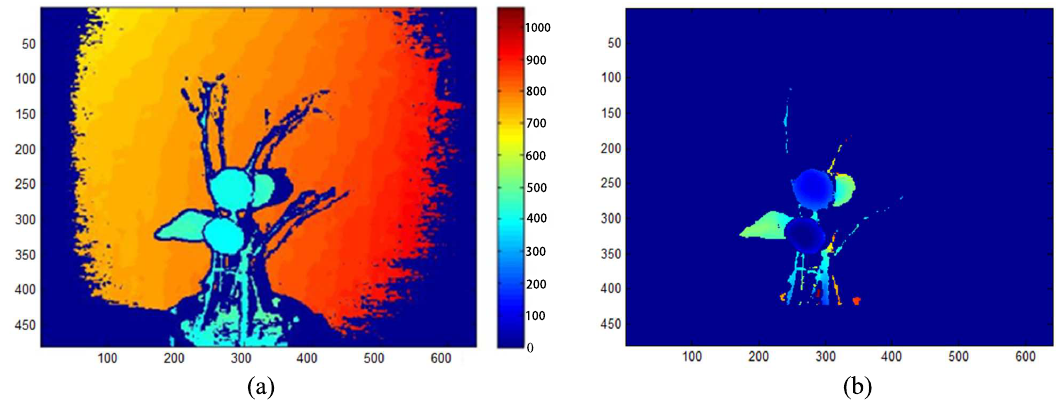
Figure 23. Elimination of foreground and background: ( a ) original depth image; ( b ) processed